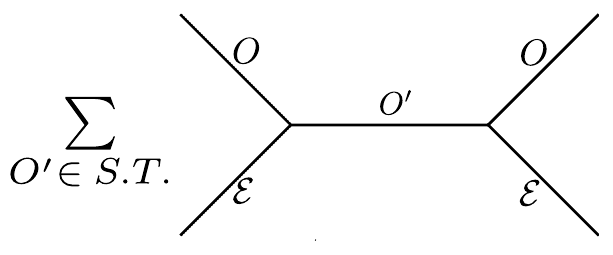
Figure 5 . The sum over operators has reduced to a sum over only the single-trace